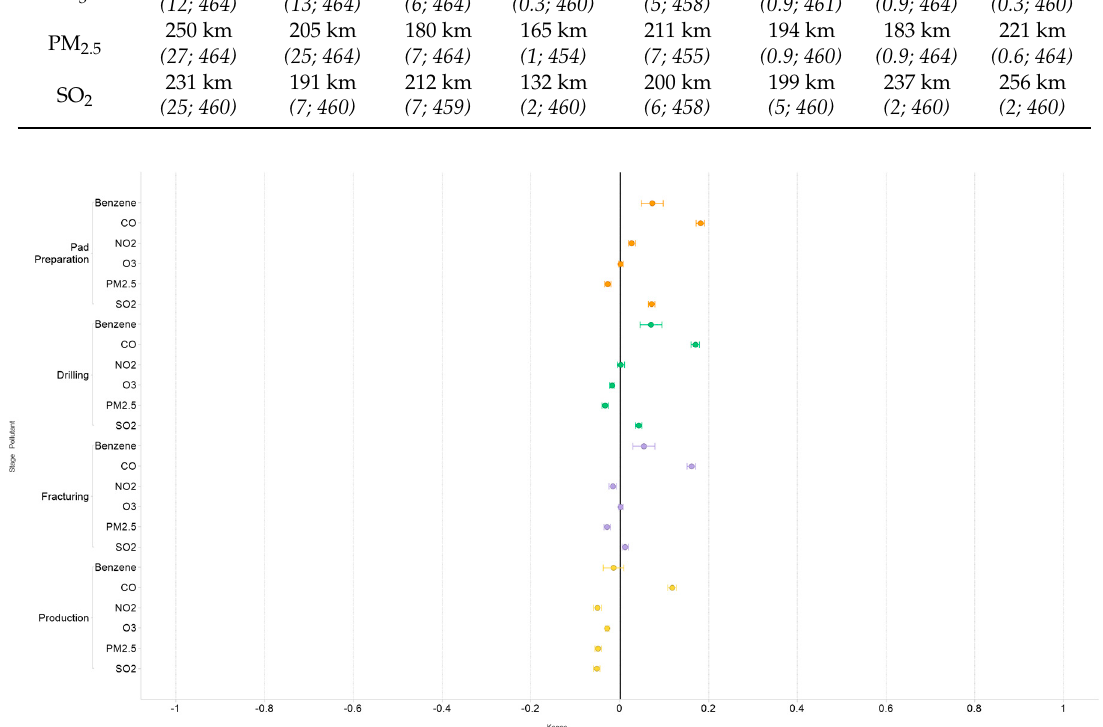
Figure 6. Weighted kappa statistics assessing agreement between quartiles of exposure for the four WA metrics and quartiles of daily mean pollutant concentrations, Pennsylvania unconventional gas wells, 2011–2015. Table 3. Results of sensitivity analysis comparing weighted kappa values for monitors with 10- and 30-km buffer zones applied, and results for all monitors regardless of distance to nearest well.